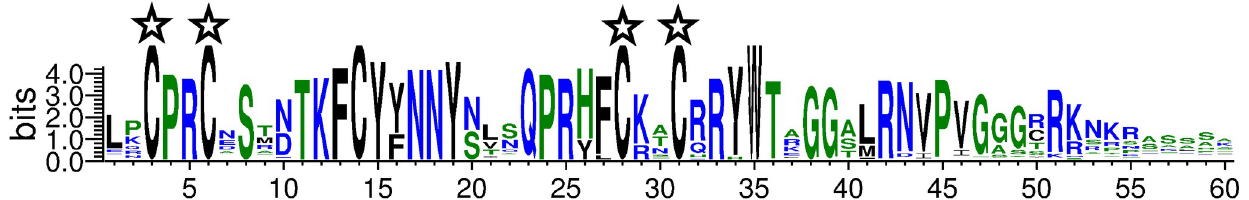
Fig 1. The distribution of all sugarcane Dof domains at each position. Multiple alignments of all sugarcane Dof domains were performed to plot the sequence logos with ClustalW. The information content of Dof domains at each position was indicated with the bits score. The four conserved cysteine residues of SsDof domains were indicated with the